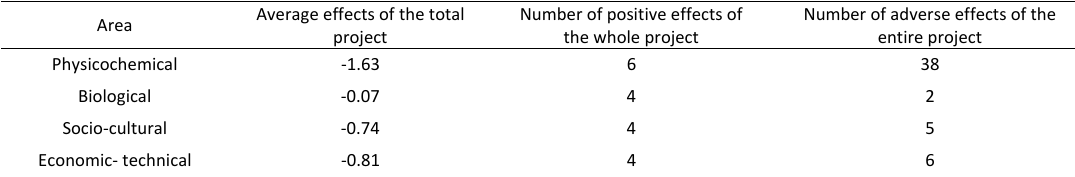
Table 3: Summary of the entire project of implementing the factory construction plan, construction phase Area